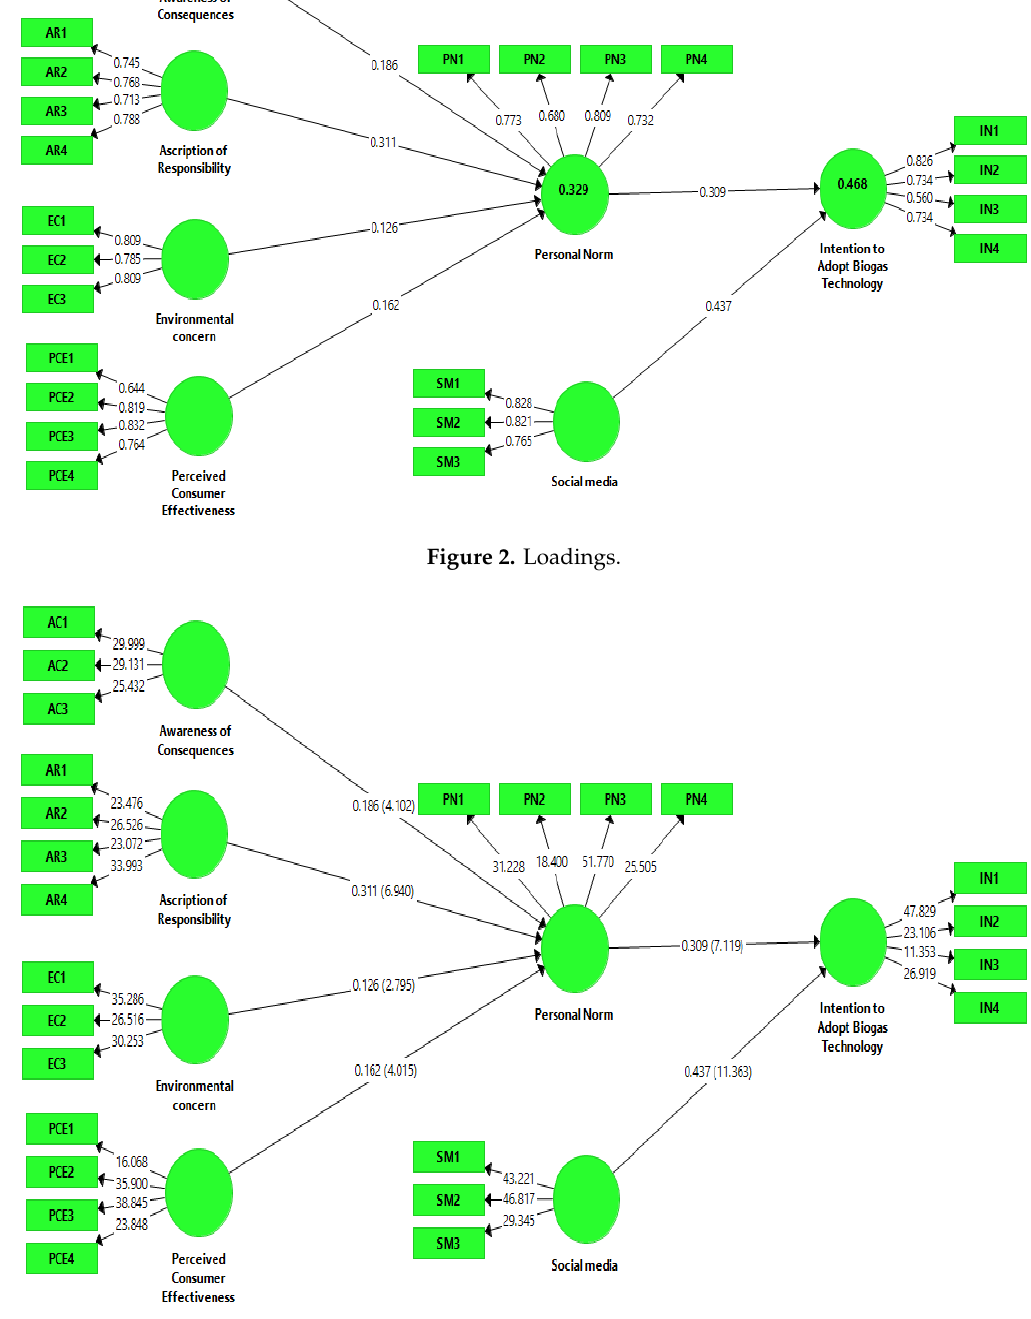
Figure 3. Structural model evaluation (bootstrap).